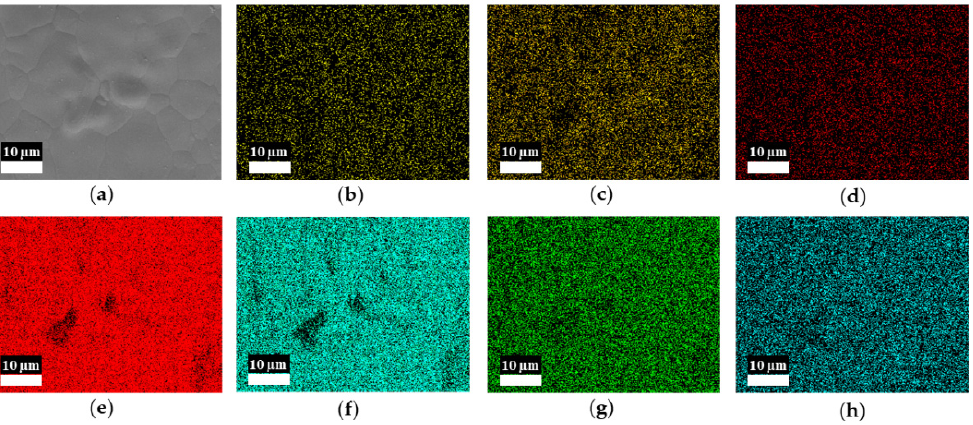
Figure 3. EDS mappings of the 0.65- μ m-thick Ti-Hf-V-Zr NEG-film-coated 500 μ m pore size Cu foams. Original ( a ) and corresponding Cu ( b ), C ( c ), O ( d ), Hf ( e ), Zr ( f ), Ti ( g ), and V ( h ).